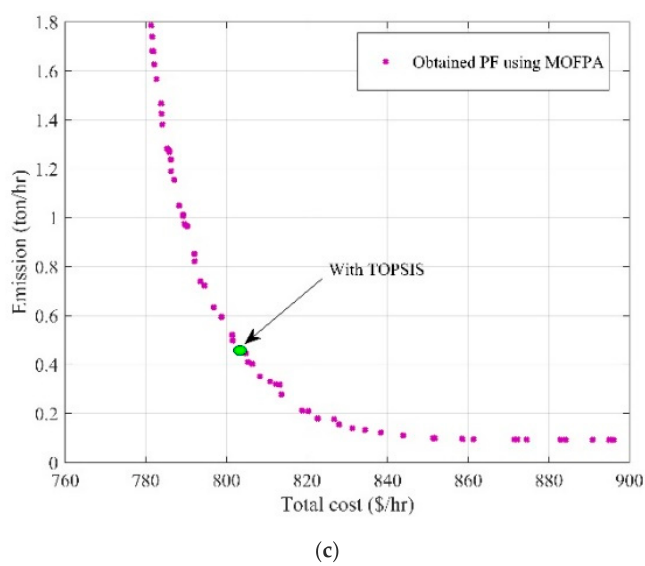
Figure 12. Obtained PFs by using MOHHO and MOFPA techniques with TOPSIS. ( a ) Obtained PF using the two optimization techniques. ( b ) Obtained PF using the MOHHO technique with TOPSIS. ( c ) Obtained PF using the MOFPA technique with TOPSIS. Table 8. Detailed numerical results of the optimization techniques for scenario III. State Variables Min